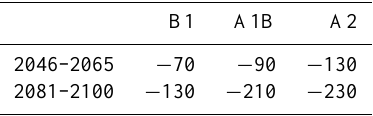
Table 2. The same as Table 1, but for mean annual precipitation (in mm). 1961–1990 values are close to 910mm in the reanalysis